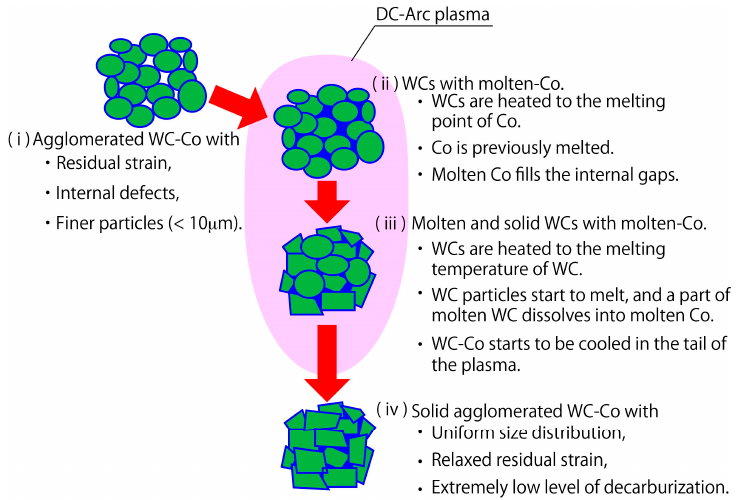
Figure 14. Morphological changes of a WC-Co agglomerated powder during the plasma process.